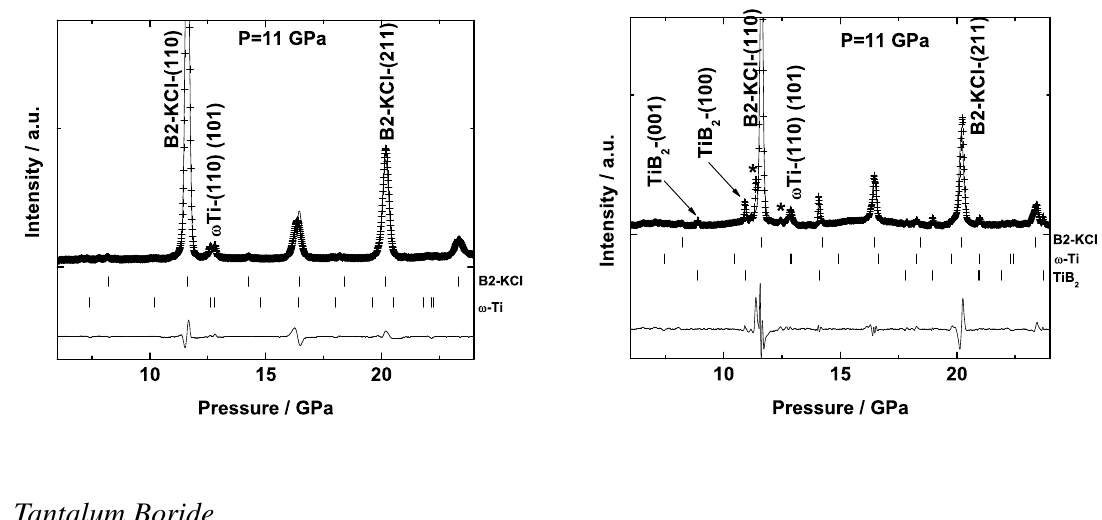
Figure 17. X-ray diffraction pattern before laser heating (left) and after laser heating (right) a mixture of titanium and boron in a DAC ( λ = 0.4958